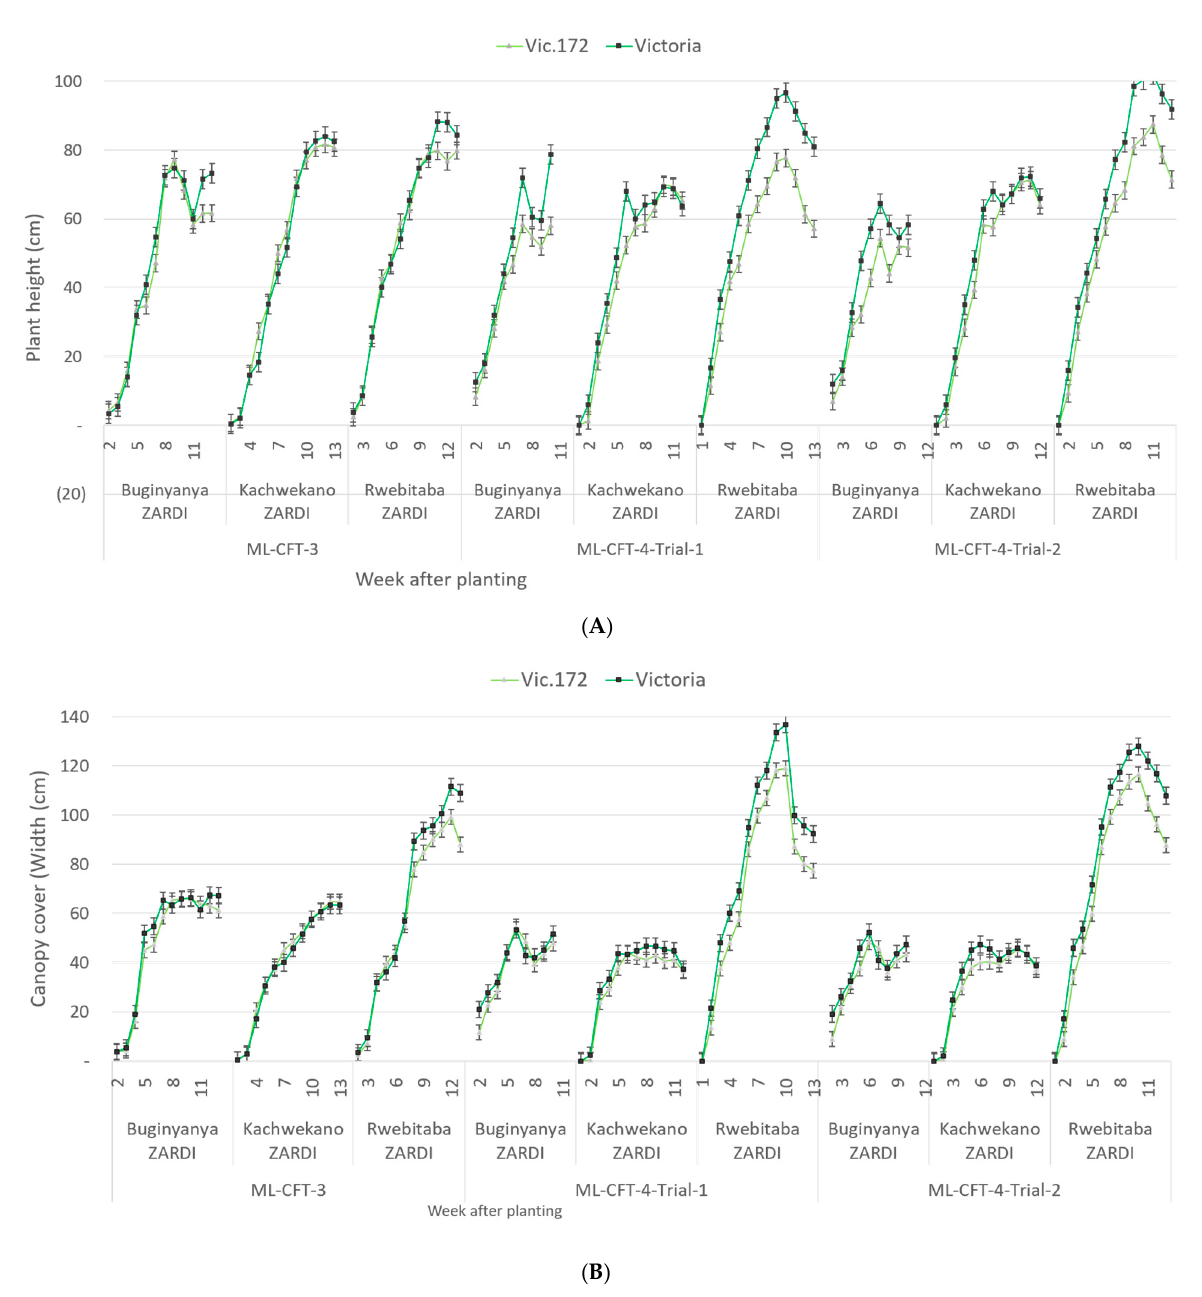
Figure 4. Plant growth of canopy of the transgenic event Vic.172 (light green) and the variety Victoria (green) plots at three locations during three trials measured by the average height ( A ) and width ( B ) of potato rows. Error bar represents the standard error.